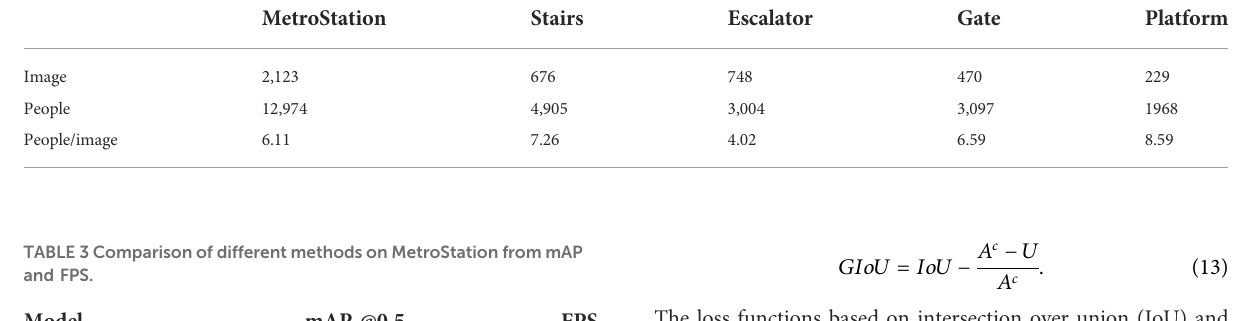
TABLE 2 Density comparison of MetroStation and its subsets.